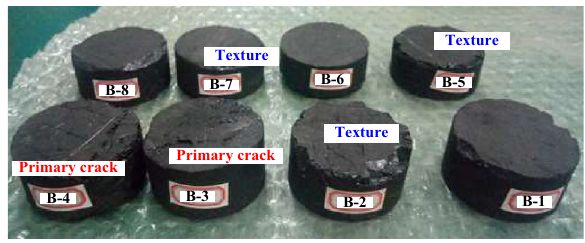
Figure 2. Overview of the test specimens.